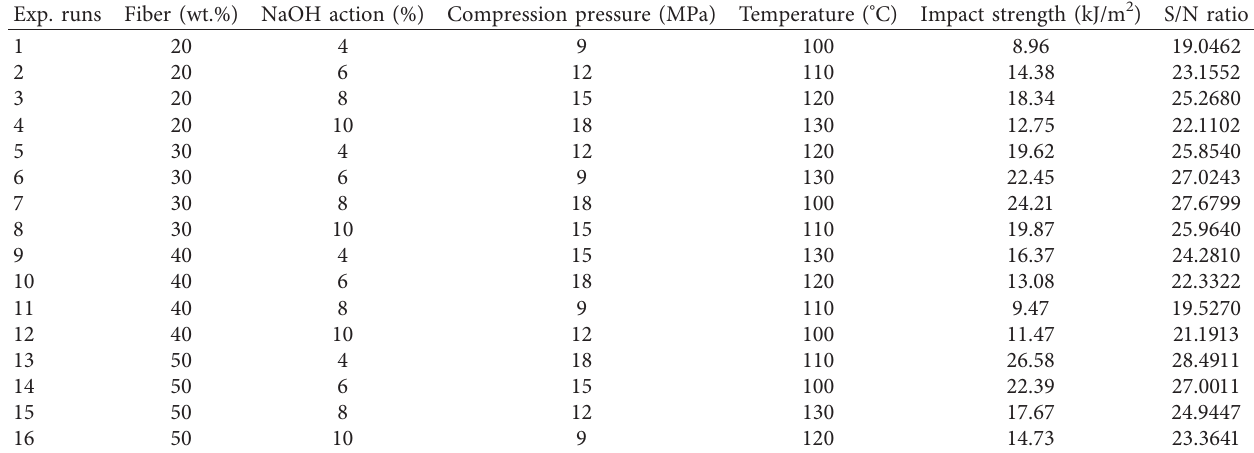
Table 5: Summarization of impact strength with the influence of